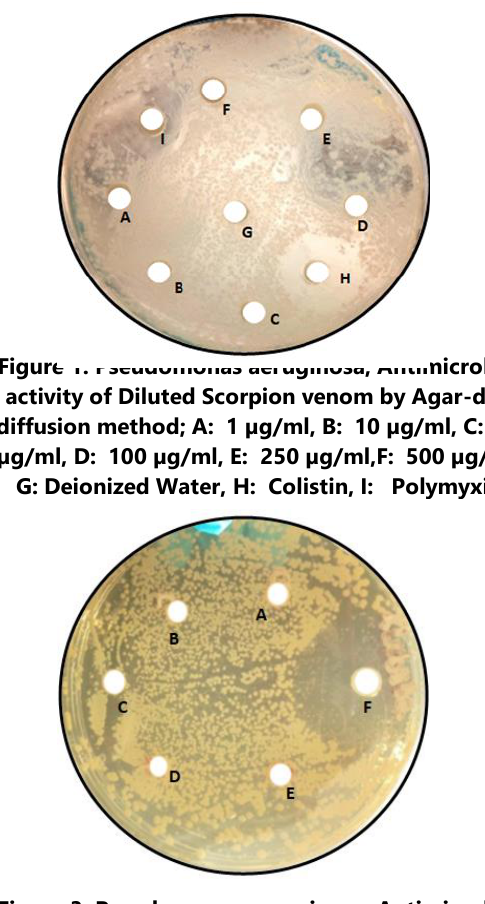
Figure 4: Acinetobactor baumannii; Antimicrobial activity of Diluted Scorpion venom by Agar-disc diffusion method; A: 1